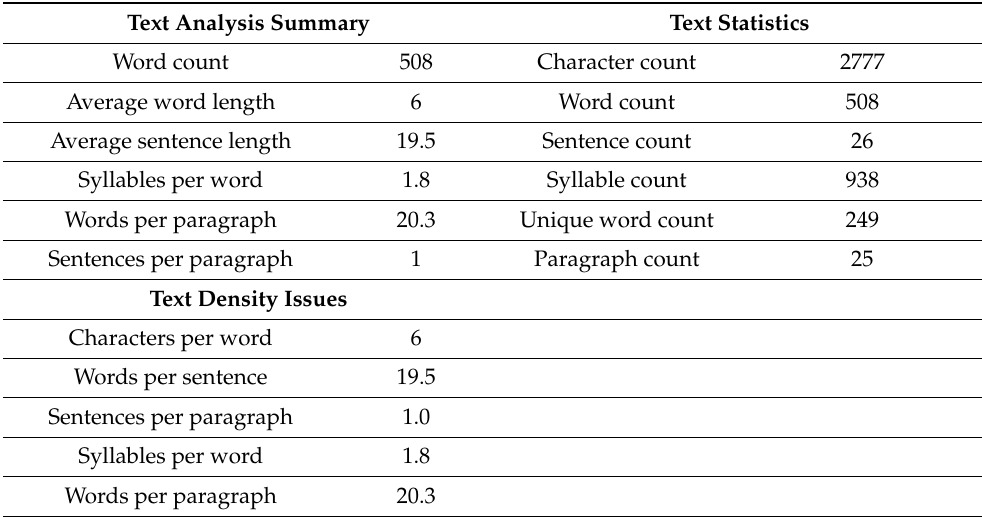
Table 3. Text Statistics for Online Exercise Content (Source: Advanced Text Analyzer).